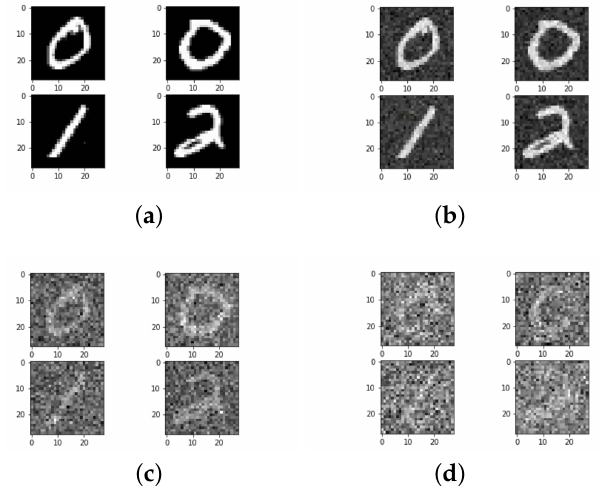
Figure 5. Examples of MNIST images corrupted by various amounts of additive Gaussian noise as used in our experiments. ( a ) Original, no noise. ( b ) Gaussian noise, zero mean, 0.1 STD. ( c ) Gaussian noise, zero mean, 0.5 STD. ( d ) Gaussian noise, zero mean, 1.0 STD.